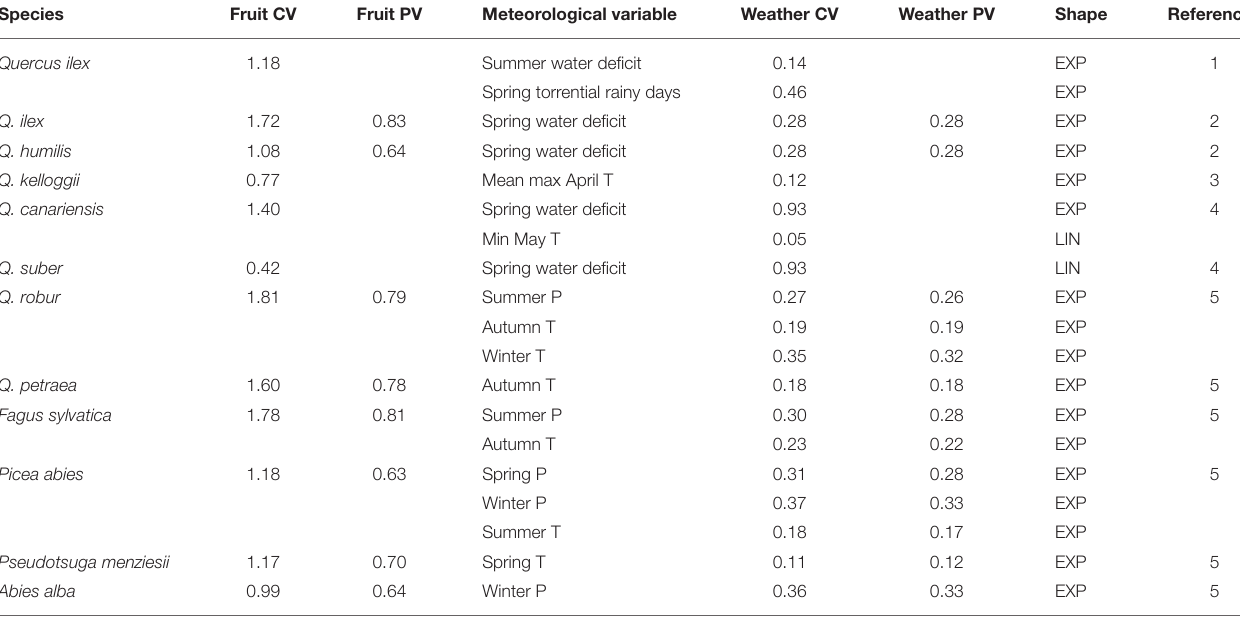
TABLE 1 | Examples extracted from the literature showing the differences in the CVs and PVs of weather and fruit production for linear and exponential relationships. Species Fruit CV Fruit